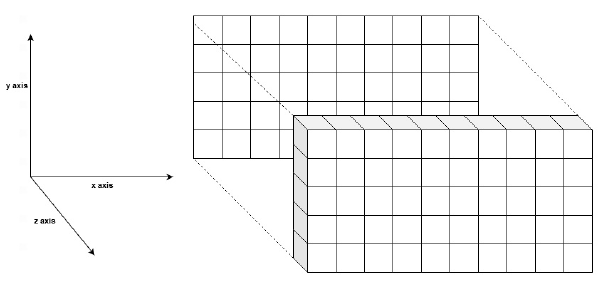
Figure 5. Single flow input visualization. The x axis stands for the number of features of each flow, the y represents the number of samples and the z , required for the LSTM input, corresponds to the number of timesteps (1 timestep for single